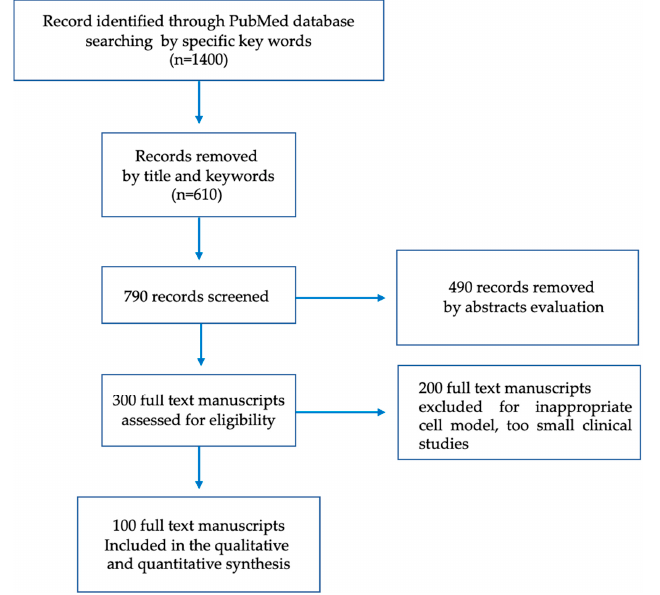
Figure 1. Flow diagram of the record screening and selection process leading to the inclusion of 100 studies.